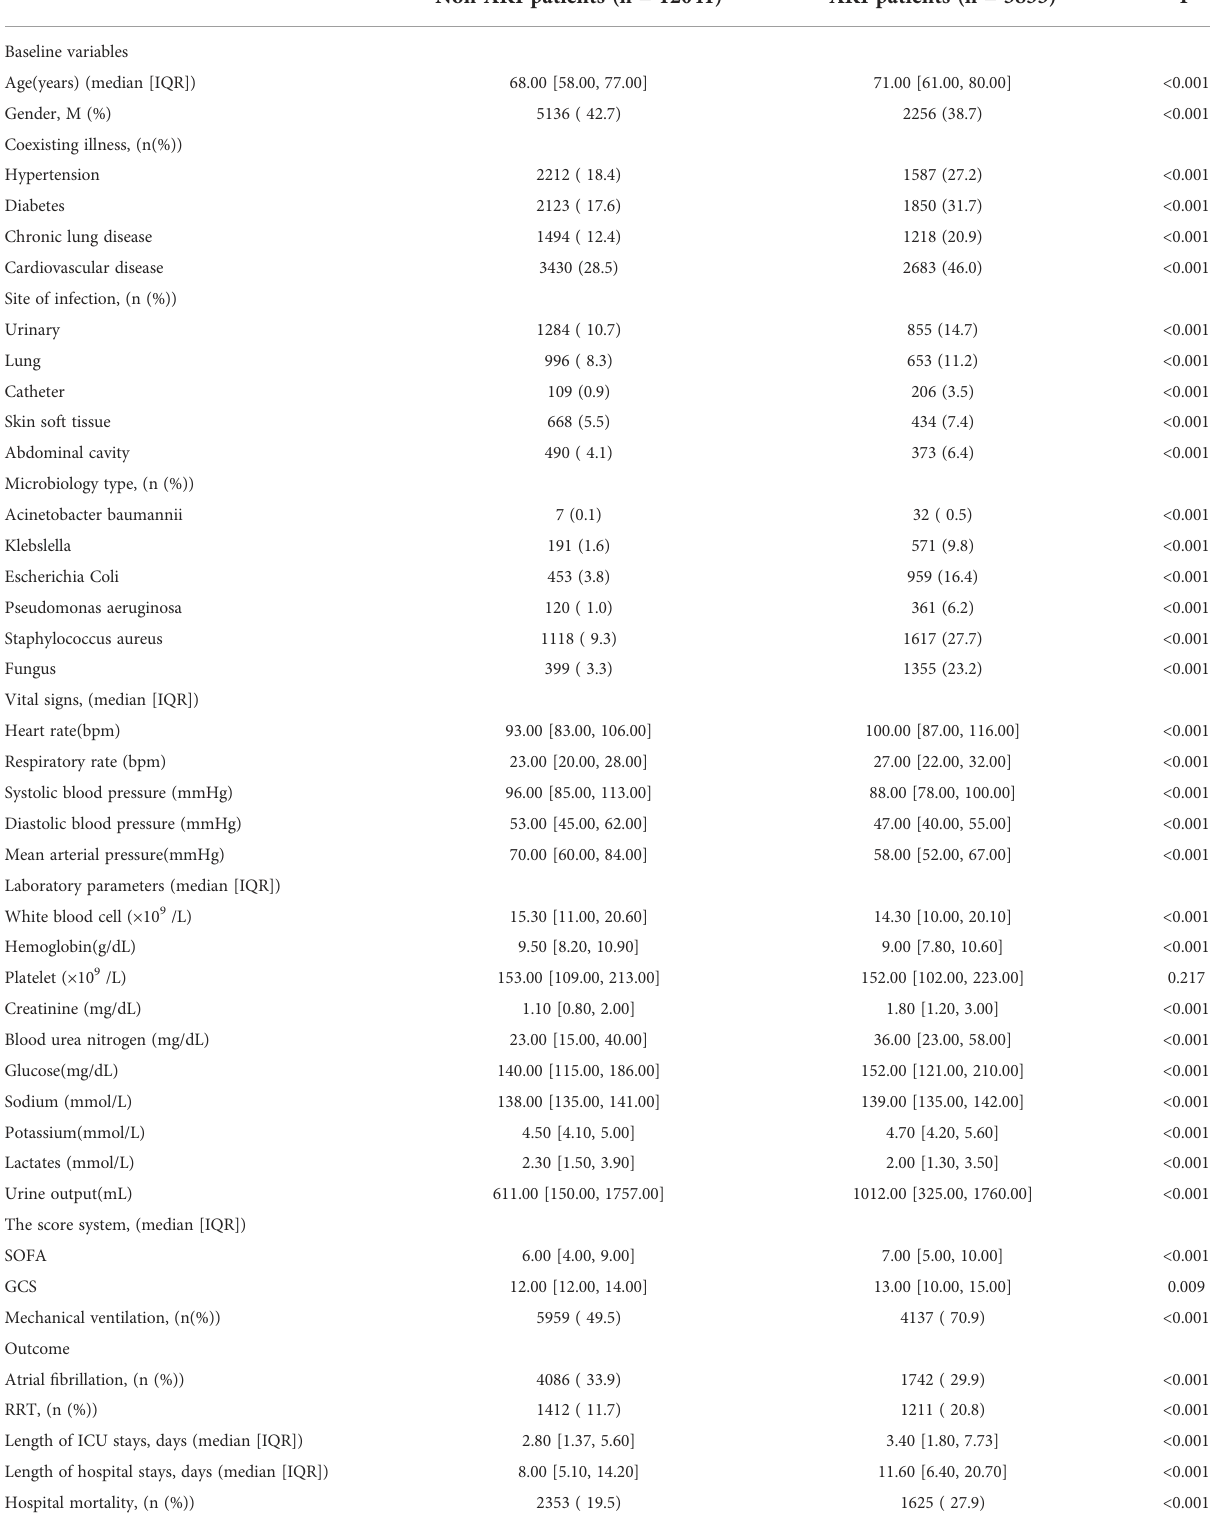
TABLE 1 Baseline characteristics and outcomes of patients with